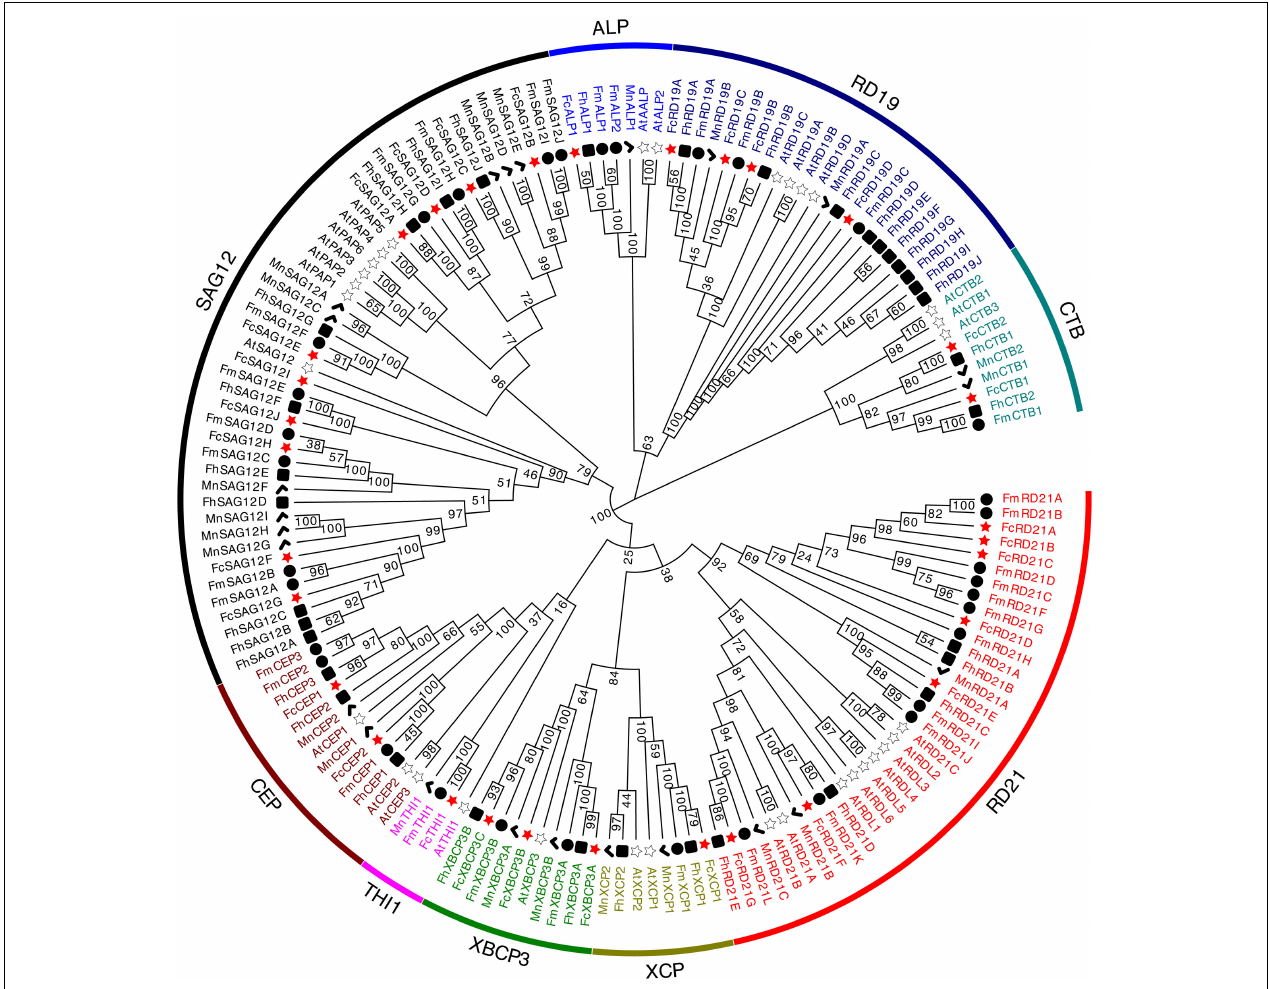
FIGURE 2 | Phylogenetic tree of 156 PLCP genes identified in Ficus carica , Arabidopsis thaliana , Morus notabilis , Ficus hispida , and Ficus microcarpa genomes. Sequence alignment was performed using ClustalW. The phylogenetic tree was constructed using the neighbor-joining method by MEGA X (1,000 bootstrap).